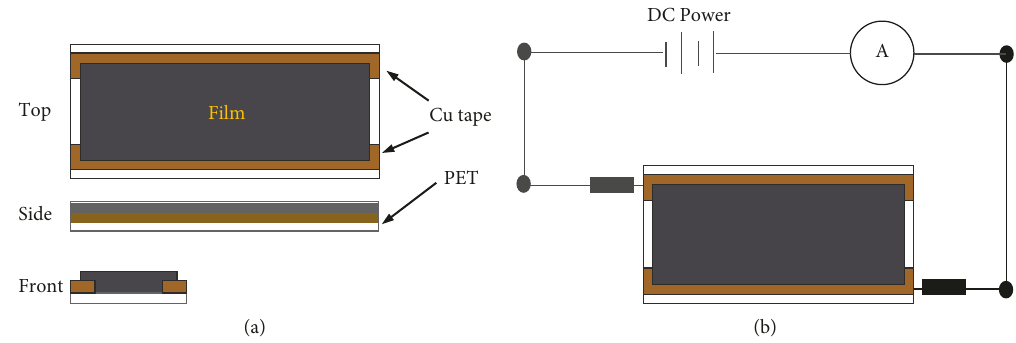
Figure 1: Schematics of (a) a heating fi lm and (b) a circuit set for the heating